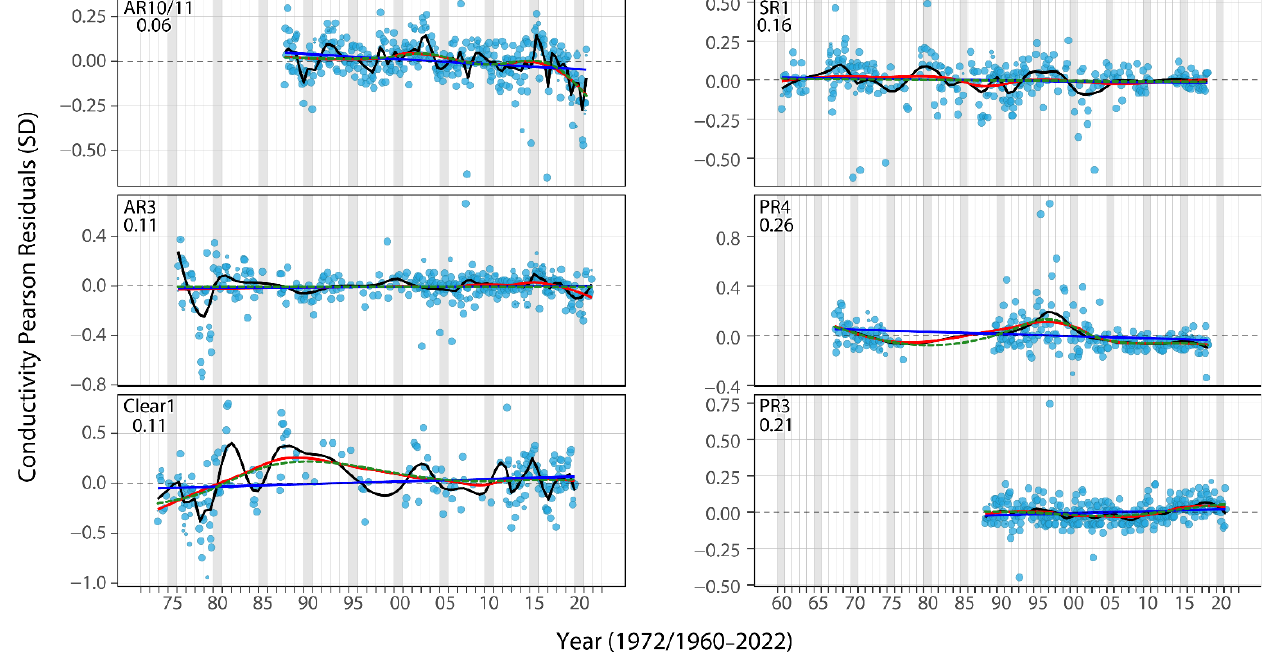
Figure 3. Pearson residuals (±Standard Deviation) of conductivity measurements in large river sites in norther Alberta; points are individual observations scaled by mean autocorrelation factors (Figure S8) and lines show smoothers (LOESS: 0.5 span in red; optimal span (values below site names) in black; GAM in green dashing; linear model in blue); site names correspond to locations in Figure 1.